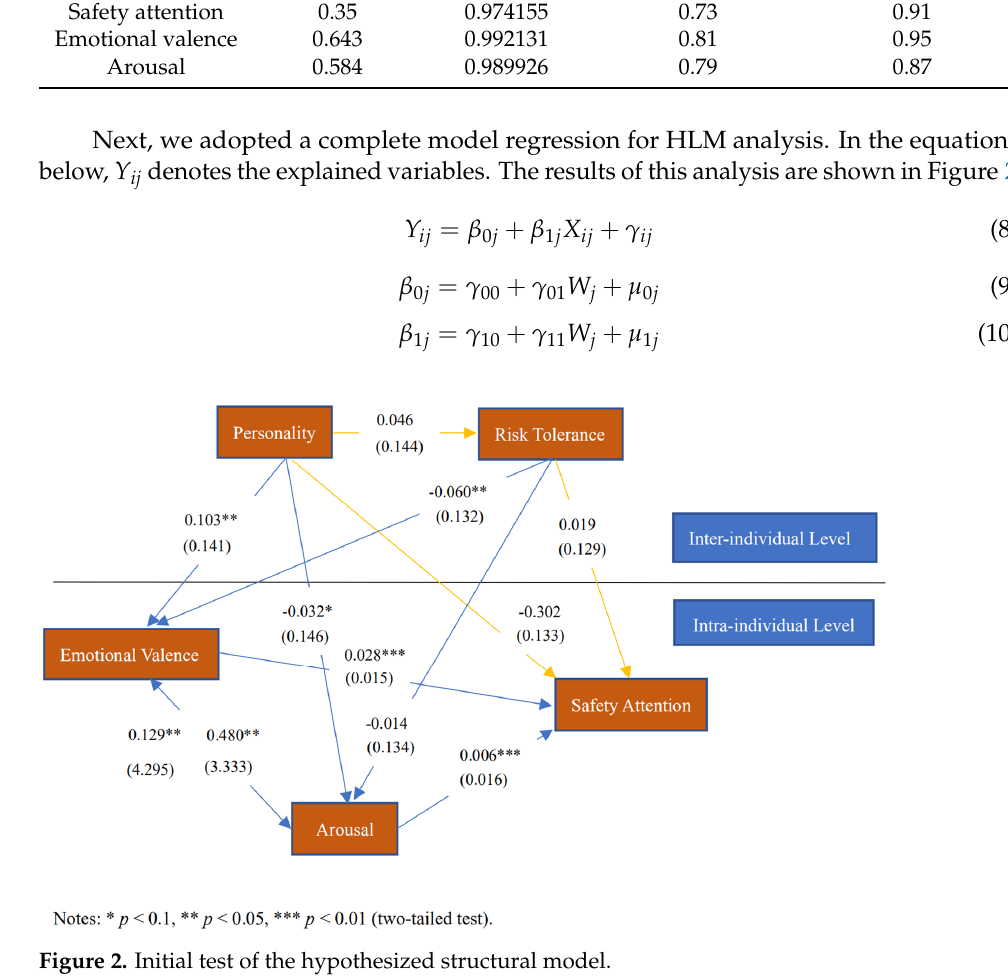
Figure 2. Initial test of the hypothesized structural